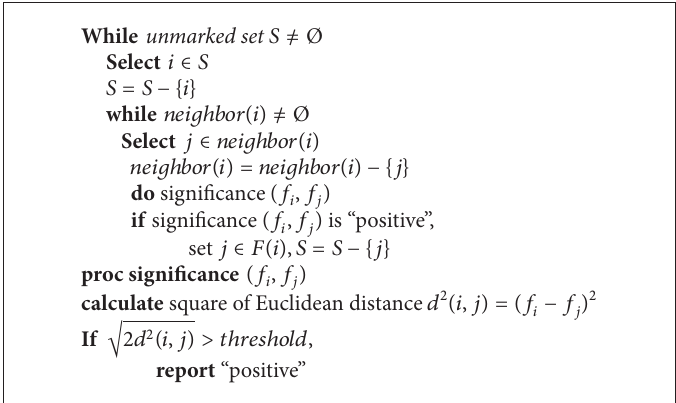
Figure 9: Example of irregular grid